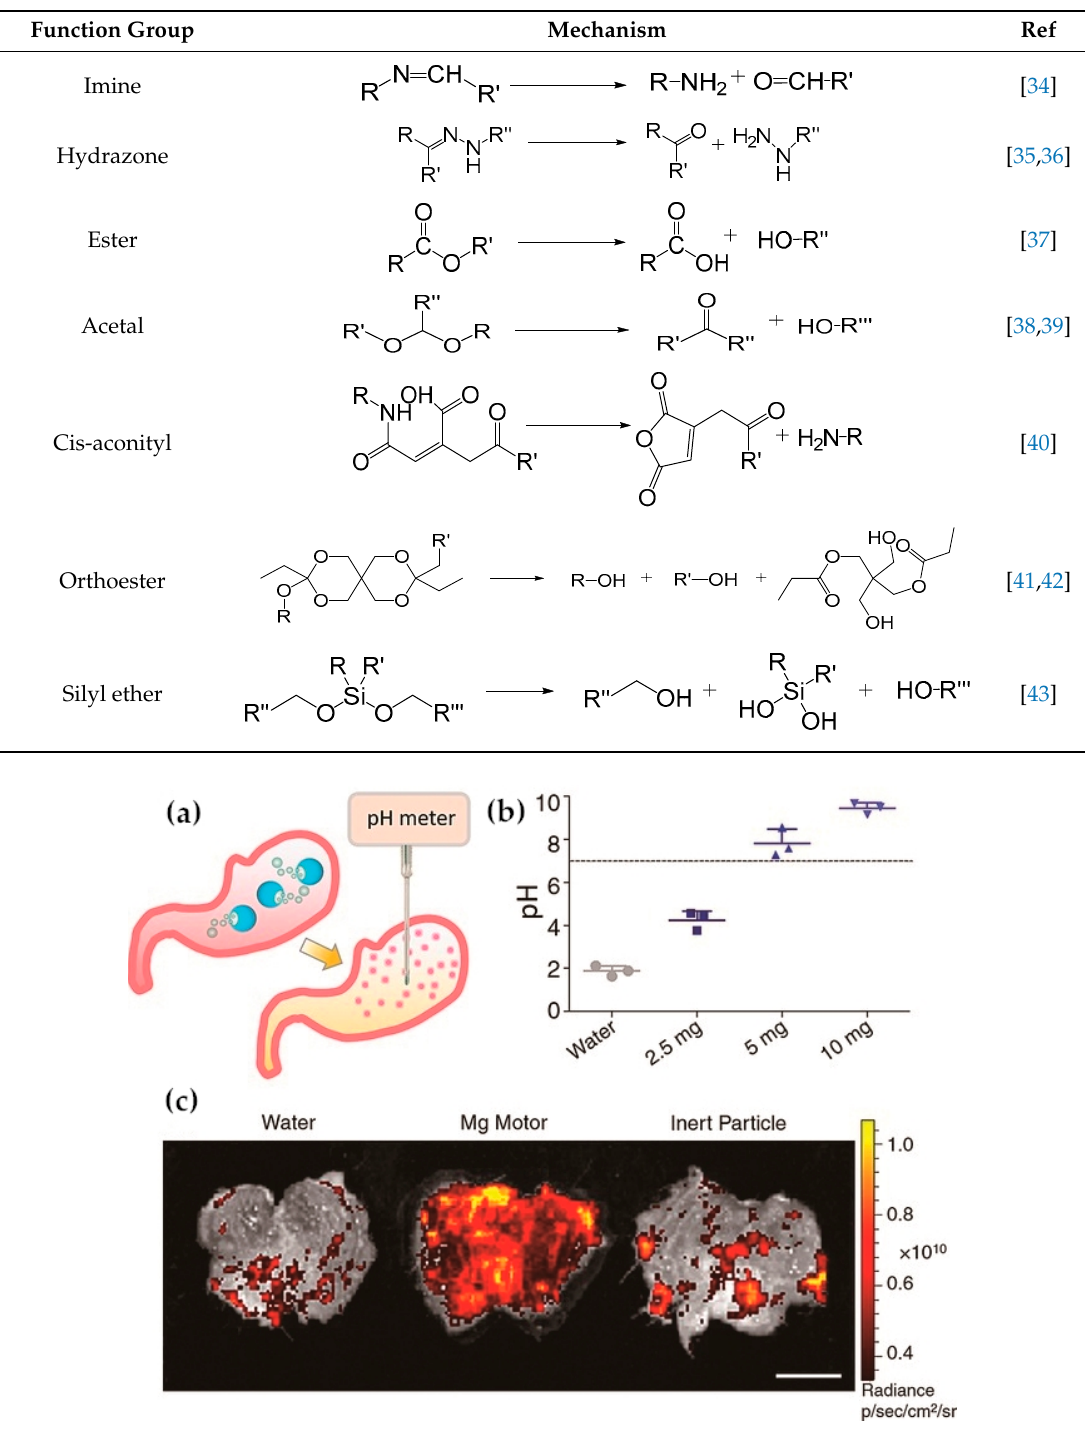
Figure 2. pH-stimulated cargo release. ( a ) Schematic illustration of the process of gastric acid neutralization by magnesium micromotor in vivo and pH measurement by microelectrode pH meter. ( b ) The pH values in the stomachs of mice after different doses of Mg micromotor were given. ( n = 3) ( c ) Twenty minutes after mice were injected with deionized water, Mg micromotors and inert polystyrene (PS) particles, superimposed fluorescent images of the whole stomach of mice were collected (both Mg micromotors and PS microparticles were loaded with DiD dye and encapsulated in a pH-sensitive polymer shell). Reproduced with permission from the publisher of corresponding reference [45].